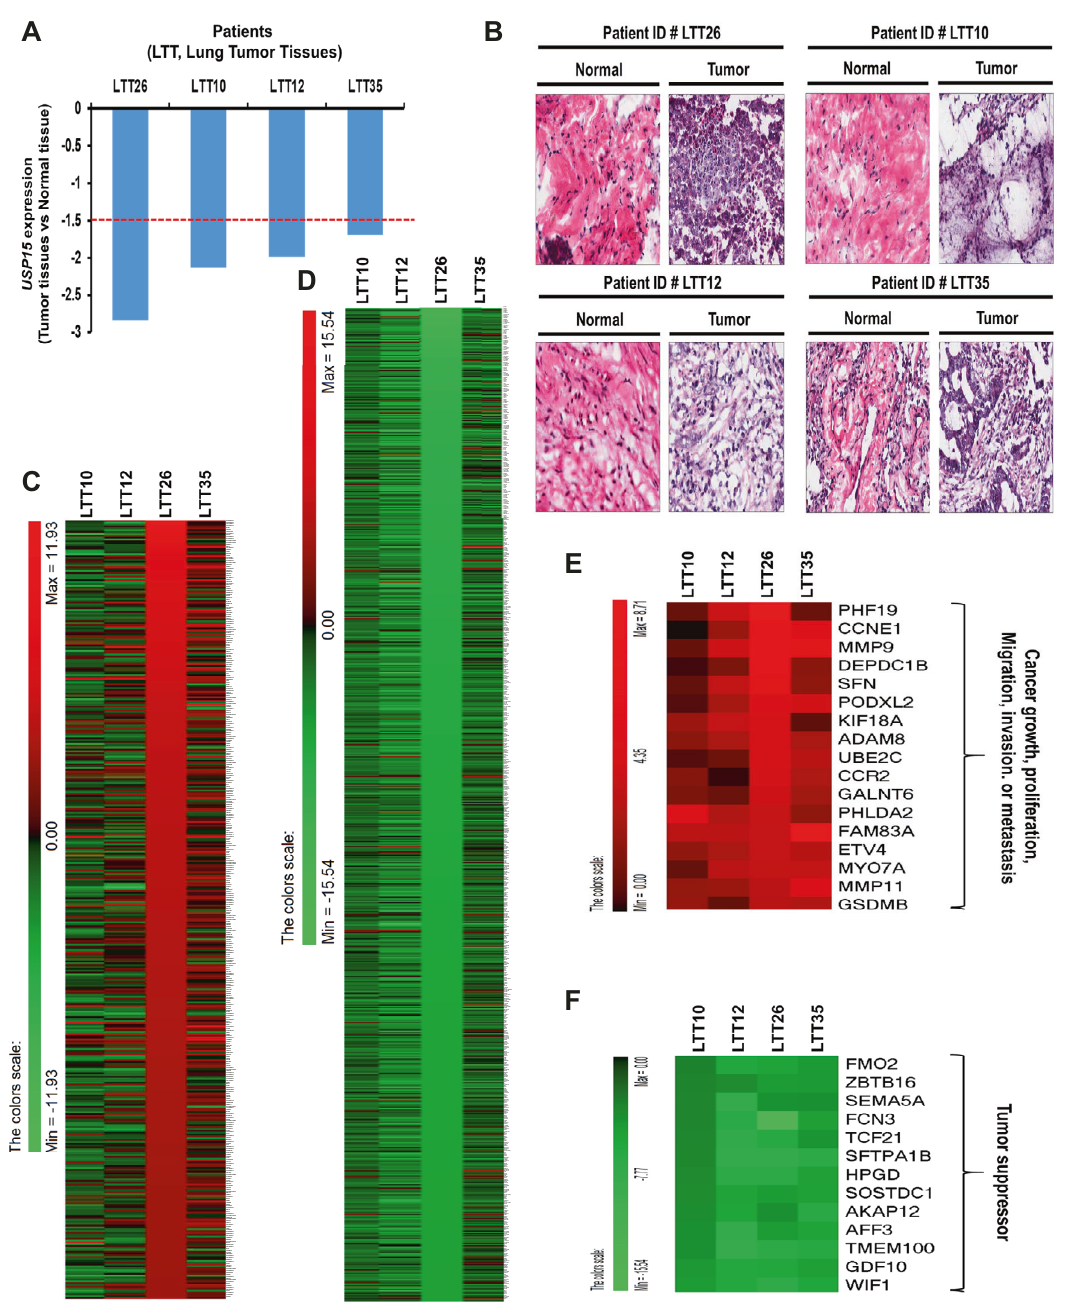
Fig. 8 NSCLC patients with low expression levels of USP15 exhibit upregulated expression levels of genes related to lung cancer progression. A Among 41 patients with primary NSCLC, four patients with NSCLC (LTT26, LTT10, LTT12, and LTT35) with low expression of USP15 were selected and their relative expression levels of USP15 were presented. B In primary lung tumor and matched normal tissues, H&E (hematoxylin and eosin) staining was performed as described in “ Materials and methods ” . C , D From tumor and matched normal tissues of LTT10, LTT12, LTT26, and LTT35 patients with NSCLC, microarray analysis was performed as described in “ Materials and methods ” . Based on the results of LTT26 patient with the lowest expression of USP15 among 41 primary NSCLC patients, upregulated genes ( C ) and downregulated genes ( D ) were sorted out and presented. E Among upregulated genes presented in ( C ), 17 different cancer-associated genes commonly upregulated in four primary NSCLC patients were sorted out and presented. F Among downregulated genes presented in ( D ), 13 different tumor suppressor genes commonly upregulated in four primary NSCLC patients were sorted out and different signaling pathways [8, 58]. As depicted in Fig. 9, TRAF6 [55, 56]. The upregulation of autophagy leads to the resistance of has oncogenic characteristics involved in cancer progression. cancer cells to various anticancer drugs [56, 57]. Upon cellular Importantly, recent studies have reported that autophagy facil- stimuli including TLRs, IL-17R, and TNFR, TRAF6 regulates tumor itates TLR-induced migration and invasion of lung cancer cells cell proliferation, survival, apoptosis, and invasion through